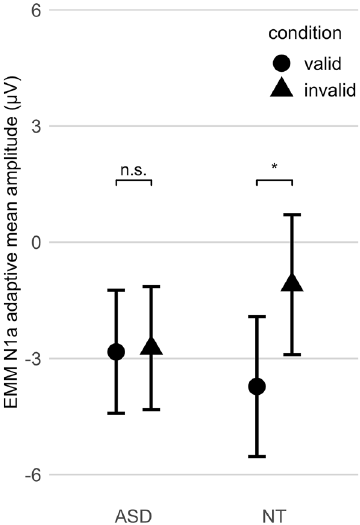
Figure 2. Significant modulation of N1a amplitude by cue validity in NT, but not in ASD. EMM: estimated marginal means; * p < 0.05; ns: not significant; ASD: Autism Spectrum Disorder; NT: neurotypical children; error bars: 95% confidence intervals. This figure was made using the R package ggplot2 68